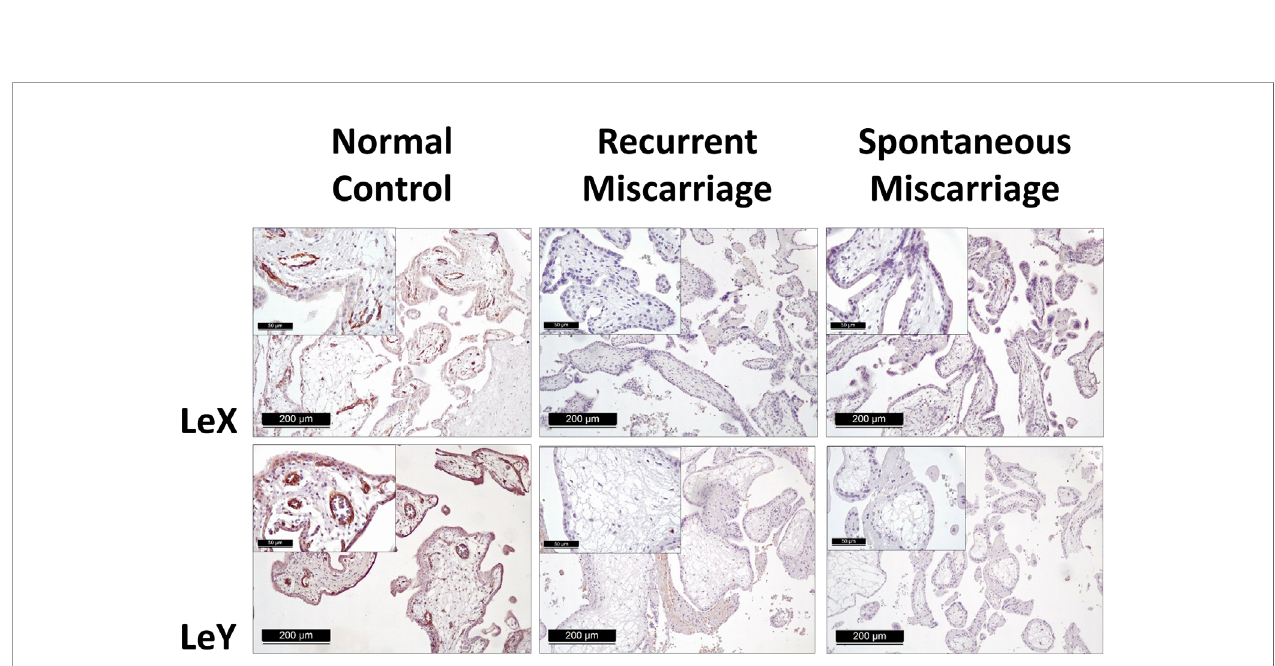
FIGURE 4 | Immunohistochemical staining of LeX and LeY in the endothelial cells of villous vessels in three groups.